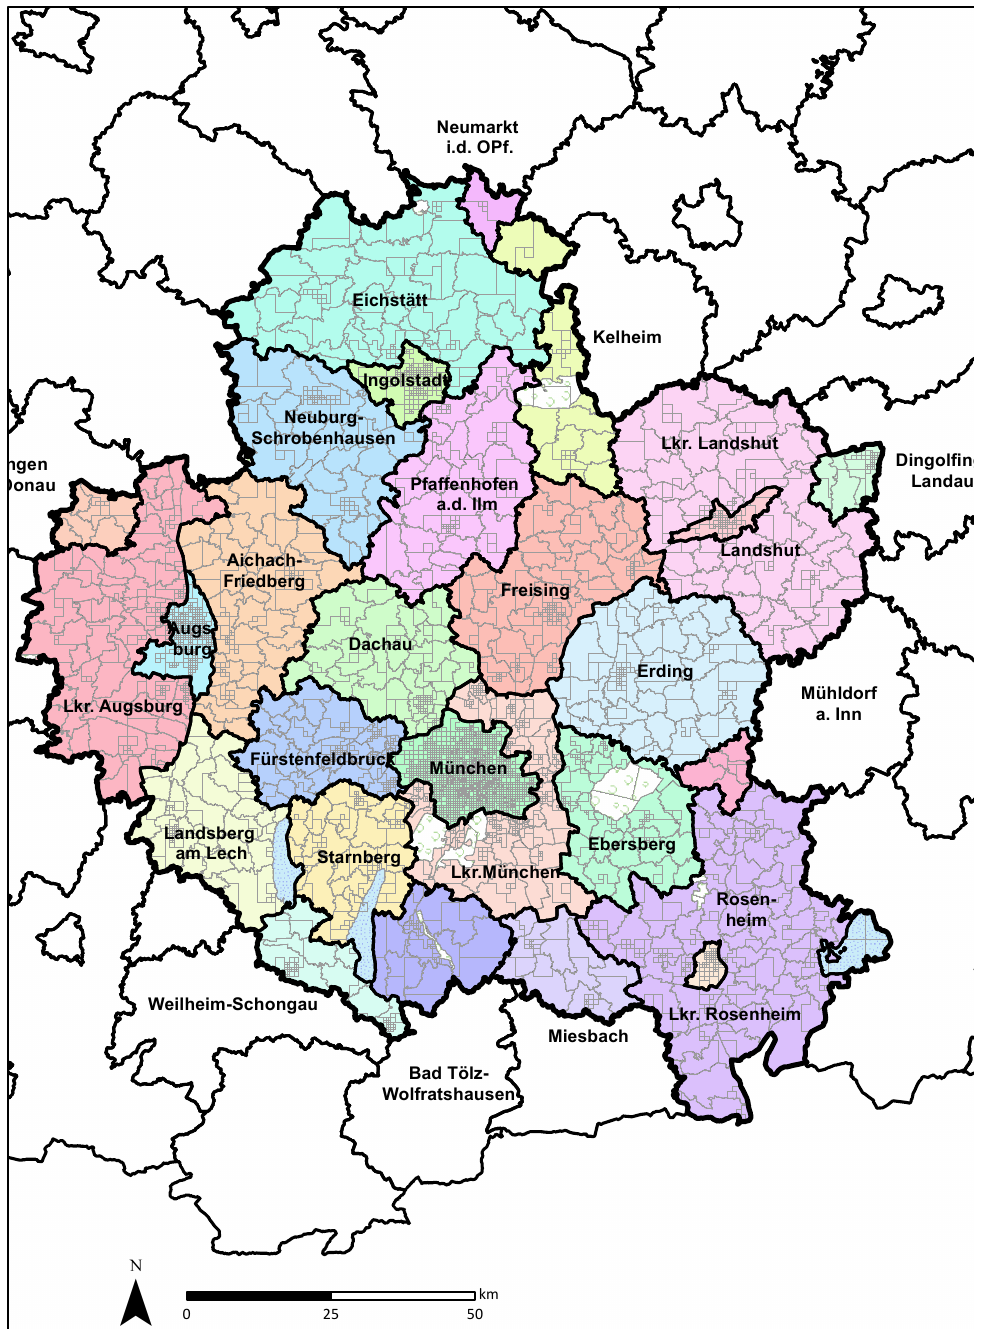
Figure 2. Greater Munich metropolitan area: counties (in color) and traffic analysis